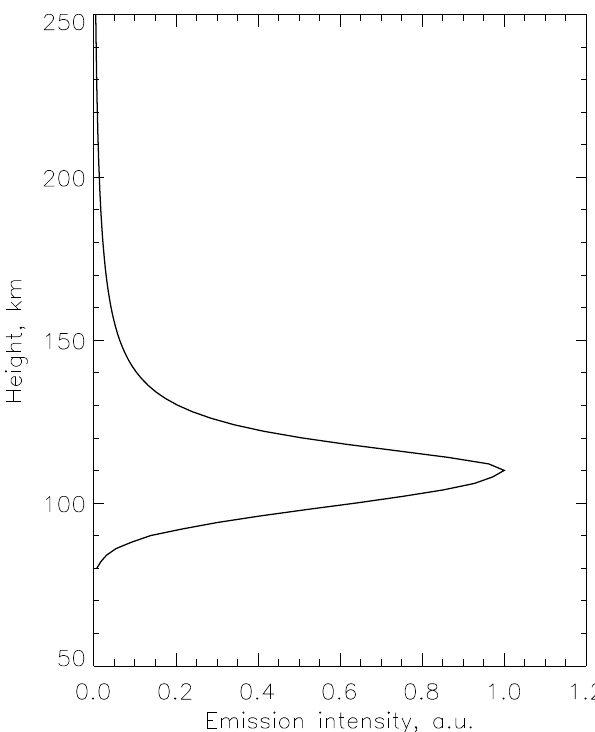
Fig. 6. Volume emission rate profile with a peak at 110 km, used when generating the synthetic images.